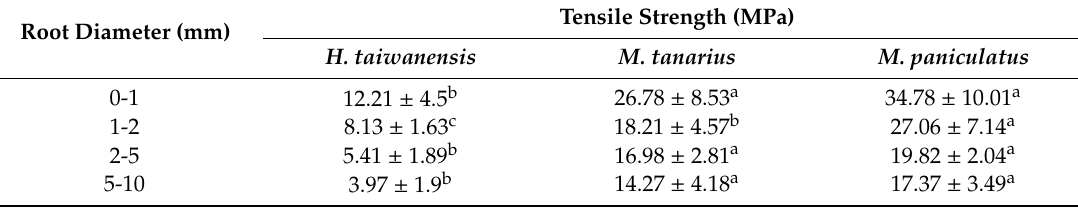
Table 9. Means ± standard deviations of root tensile strength of different root diameter classes for the three species studied.